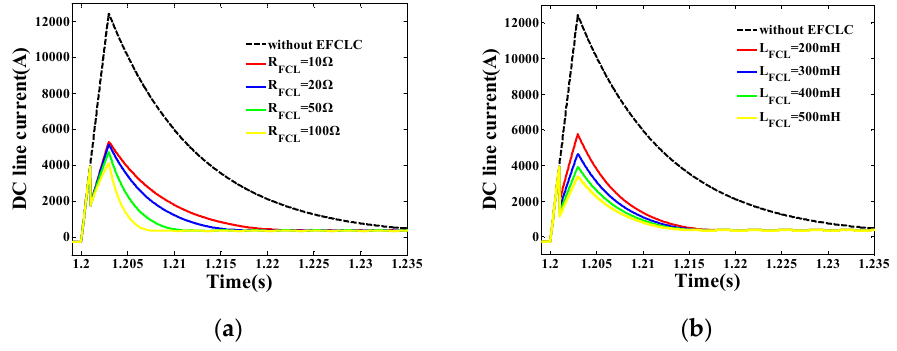
Figure 20. DC line current with variables ( a ) 𝑅 (cid:3007)(cid:3004)(cid:3013) and ( b ) 𝐿 (cid:3007)(cid:3004)(cid:3013) .